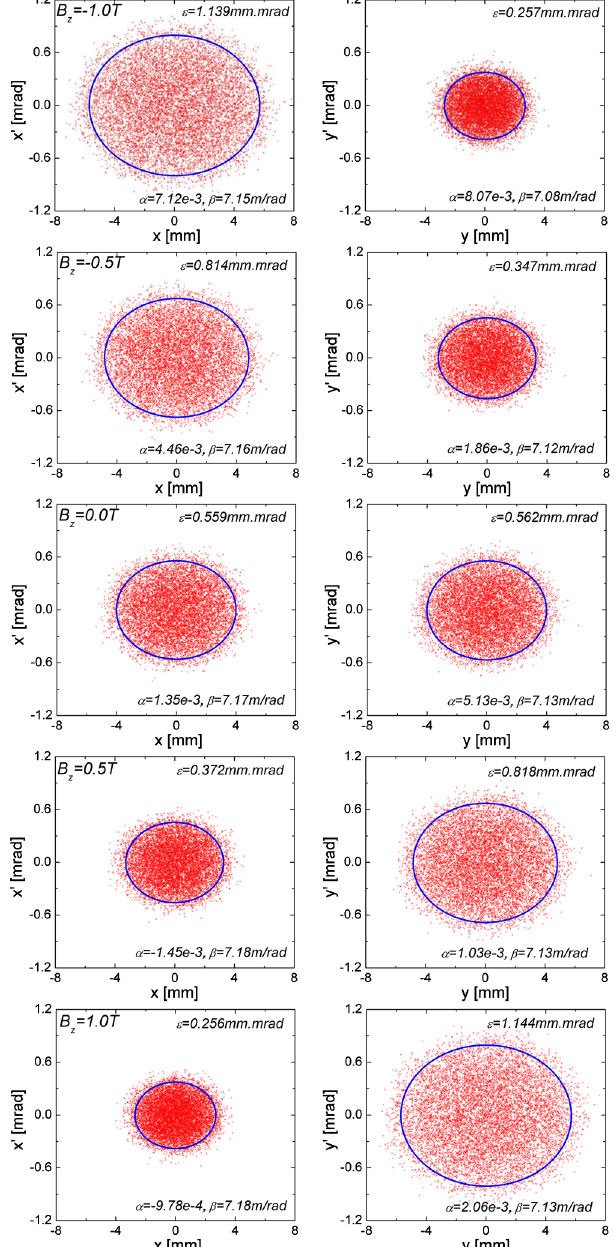
FIG. 7. The transverse emittance portraits at the exit of the beam line for different solenoid field strengths. The gradients of the quadrupoles and skew quadrupoles are constant. The rms Twiss parameters do not depend on the solenoid field